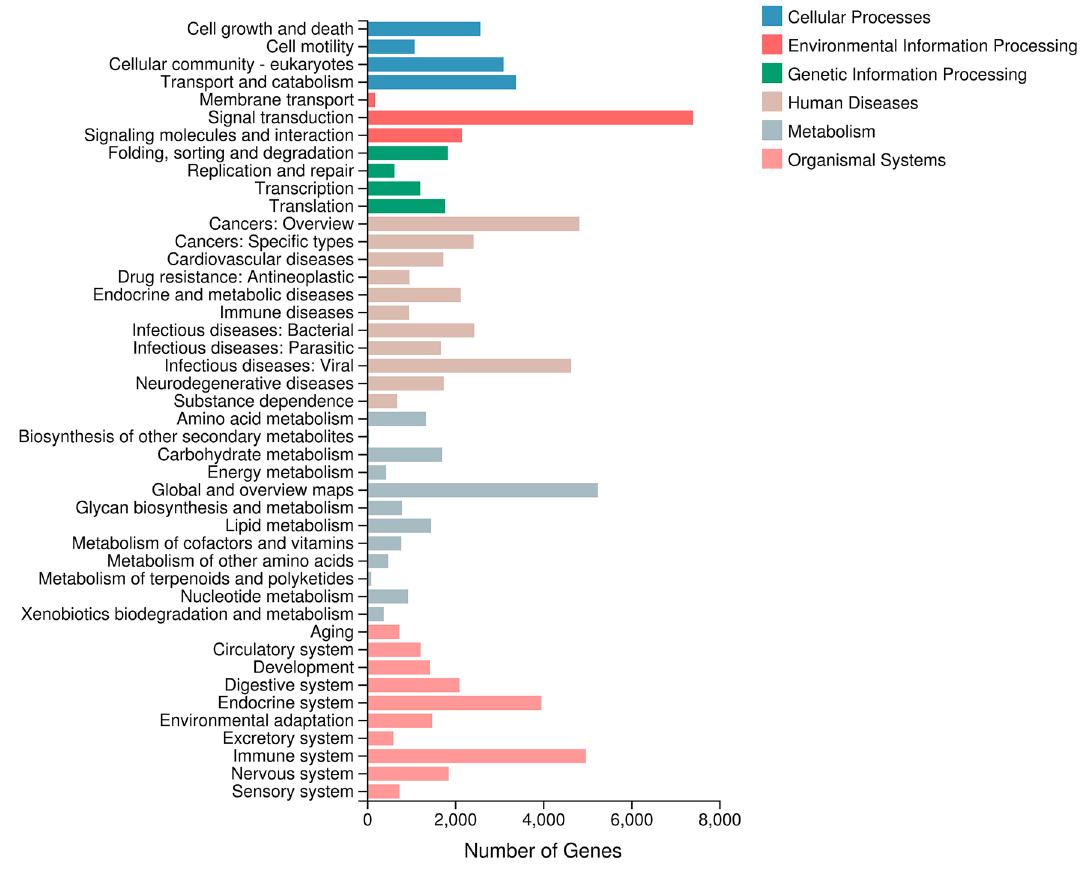
Figure 4. KEGG classifications of unigenes.